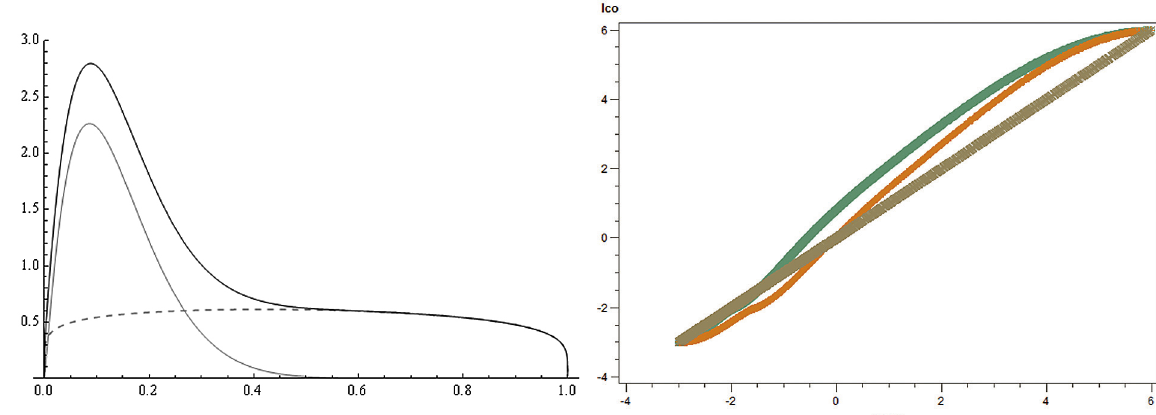
Fig. 9. Asymptotic beta distributions. Left (a): each component and the mixture. Right (b): the predicted eigenval- ues, with (brown) and without (green) an inflation adjustment [similar to equation (8), γ ˆ = 0.85], for n = 5,677 (i.e., R =